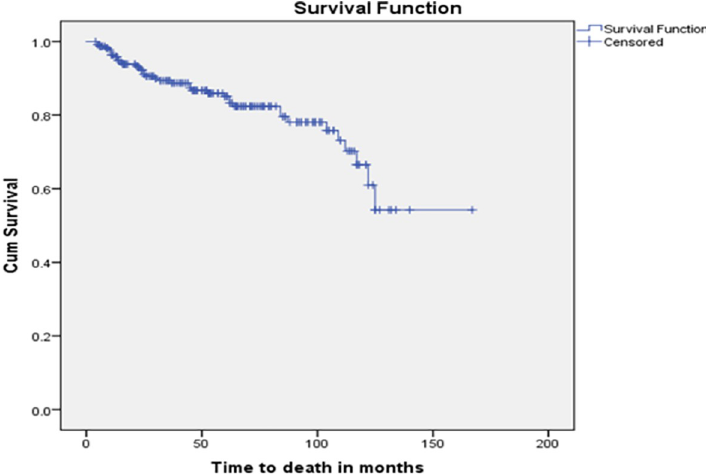
Fig 2. Kaplan-Meier of survival curve among TB and HIV co-infected children after test and treat strategies launched in northwest Ethiopia hospitals, 2021.